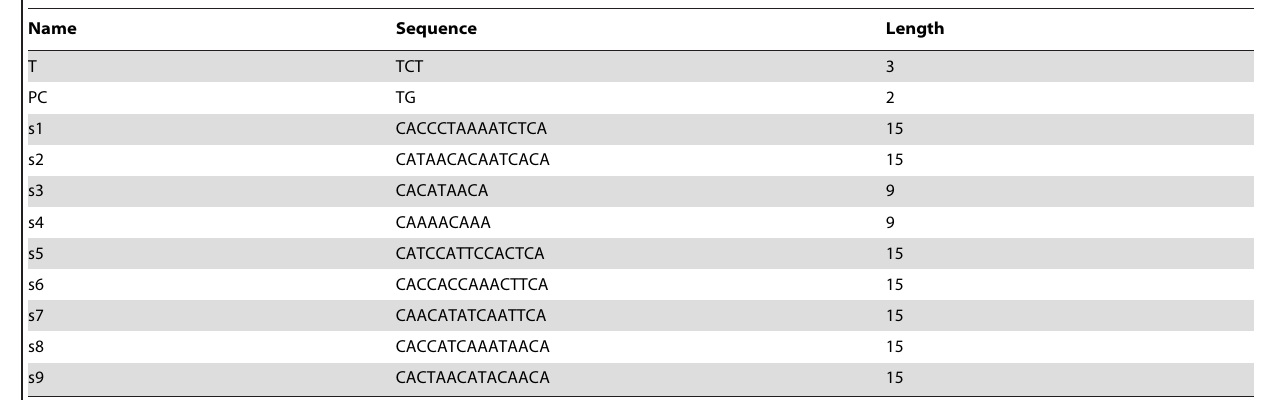
Table 3. Domains of ‘‘DNA neurons’’.